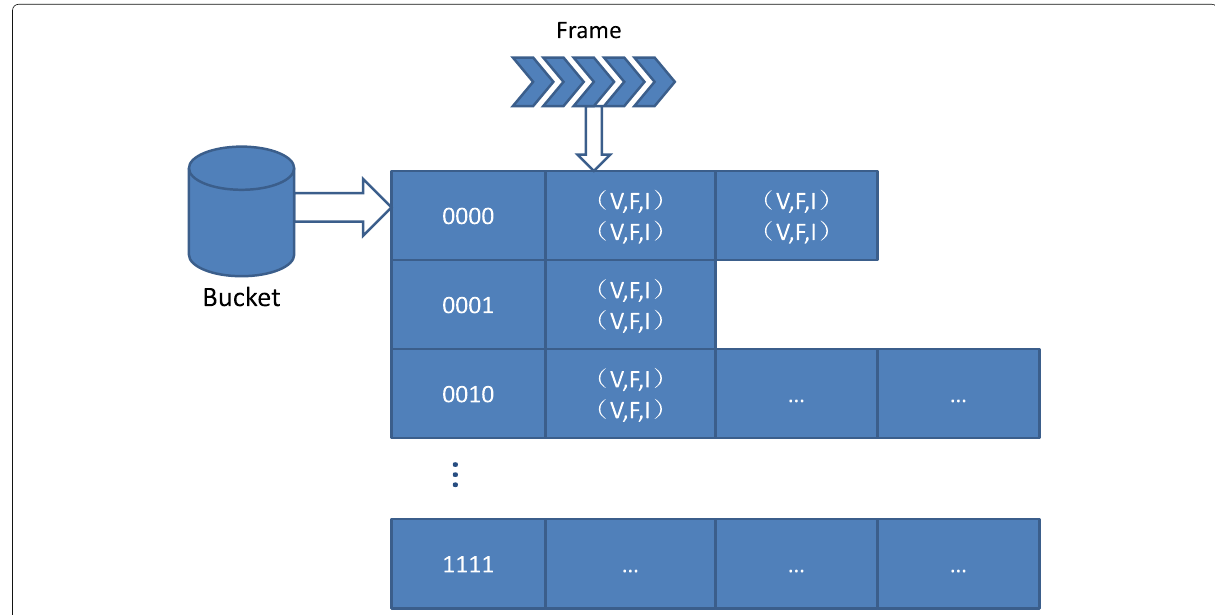
Fig. 2 Hash table structure used for the video